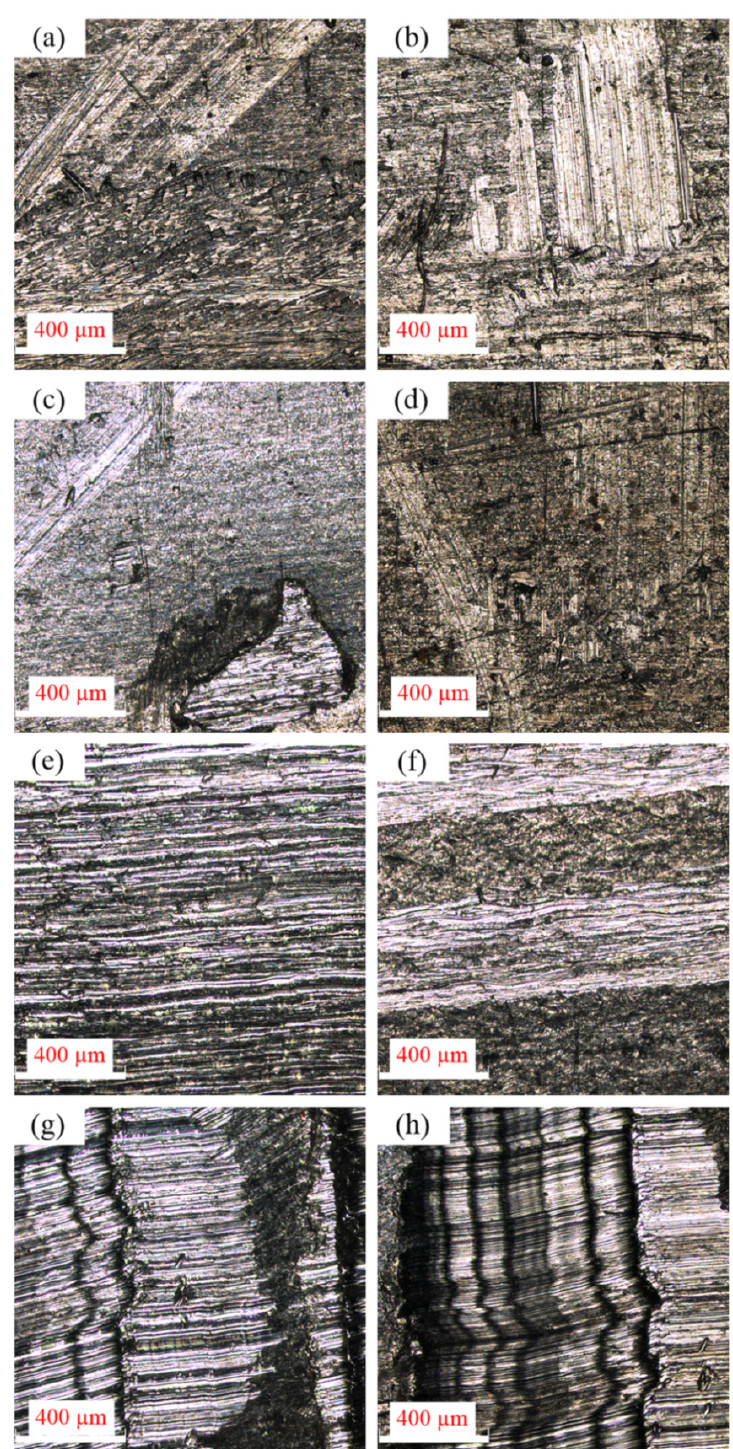
Figure 12. Micrograph of the tubular outer surface in assembled camshafts ( a – h ) [28].